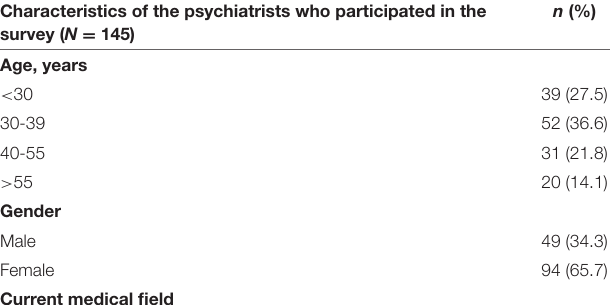
TABLE 1 | Summary of survey responses ( N = 145). Characteristics of the psychiatrists who participated in the survey ( N =